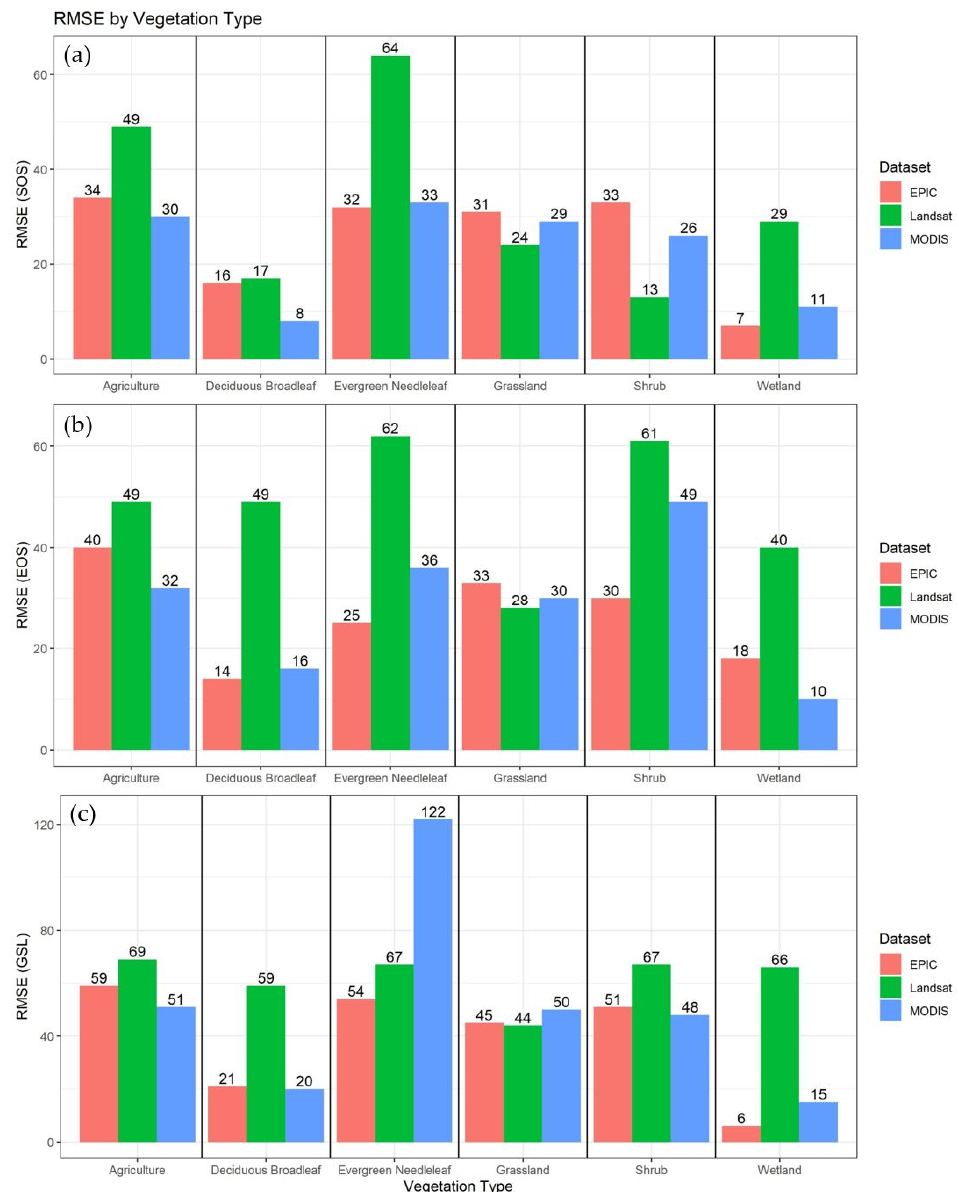
Figure 11. The Root Mean Square Error (RMSE) (unit: days) for three satellite-based datasets and PhenoCam for ( a ) SOS, ( b ) EOS, and ( c ) GSL phenology indicators, by vegetation type from 2016–2018. Note, the y-axis of Figure 10c has different increments.